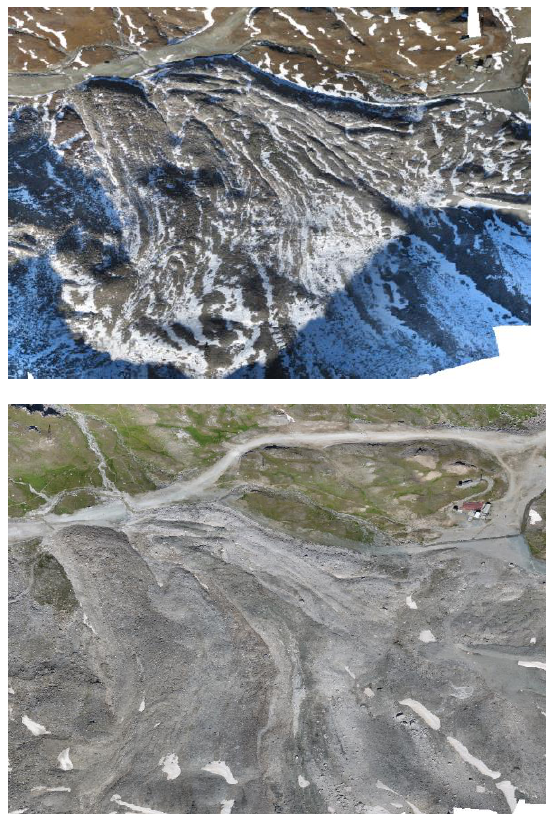
Figure 7. Top : 2012 orthophoto. Bottom : 2014 orthophoto. Automatic tracking of the displacements, both for the